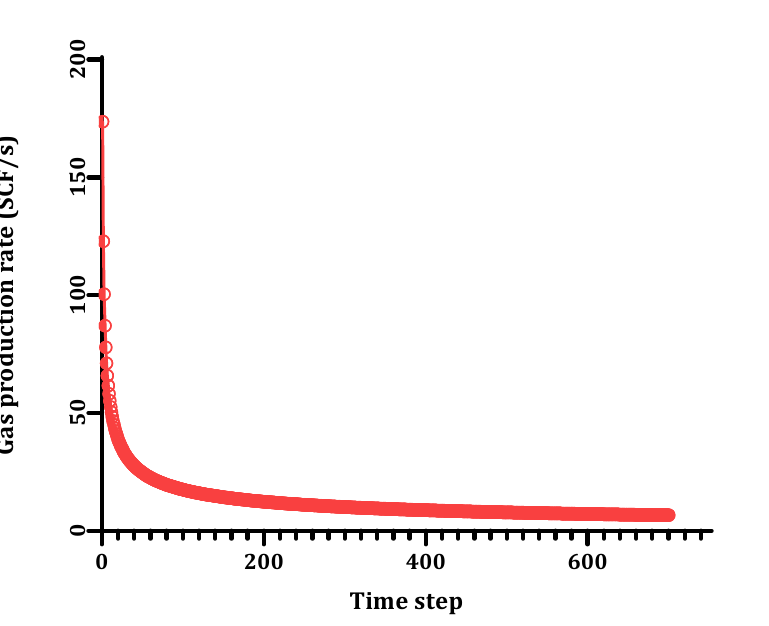
Figure 6. Gas production rate versus reservoir pressure.